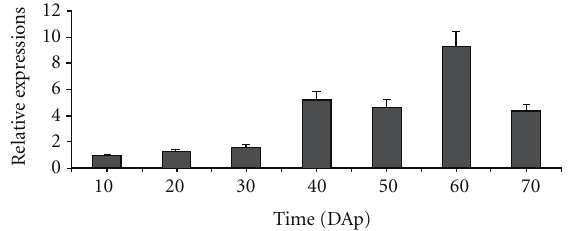
Figure 2: Real-time quantitative PCR analysis expression patterns of Ah FatA at di ff erent periods of seeds development in A. hypogaea L. The cDNA were isolated from developing seeds at 10, 20, 30, 40, 50, 60, 70 DAP. Actin from A. hypogaea L. was used as an internal control. Error bars SD. The transcript level of 10 DAP was used as the calibrator whose Ah FatA mRNA level was given as 1.